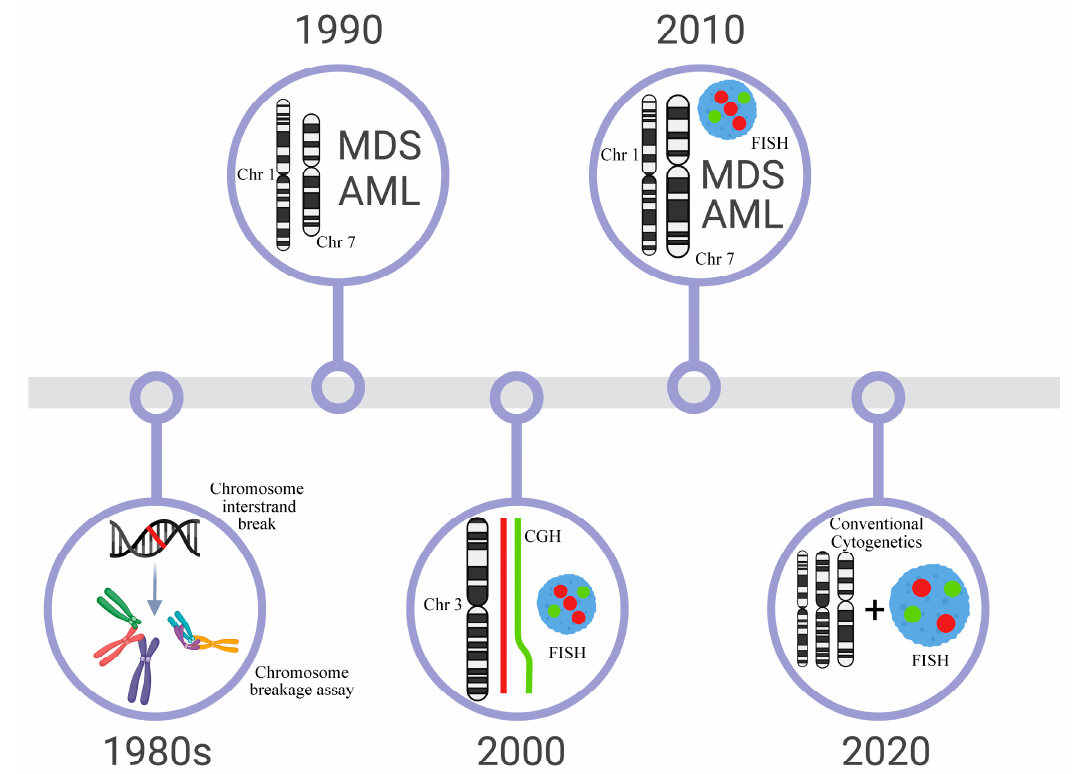
Figure 1. Timeline of the most important dates of Cytogenetics in FA. The first protocols for the diagnosis of FA with clastogenic agents were developed in the 1980s. In the 1990s, literature reviews and multicentric studies showed that changes in 1q+ and − 7 were recurrent in the bone marrow and could be related to FA progression to MDS/AML. However, aberrations commonly observed in AML, t(8;21), t(15;17), and inv(16) were not seen in these patients. Molecular techniques (FISH, CGH, CGHarray, SNParray) were widely used in the 2000s and one of the big discoveries was the definition of extra material in 3q, a subtle alteration that is cryptically embedded in the